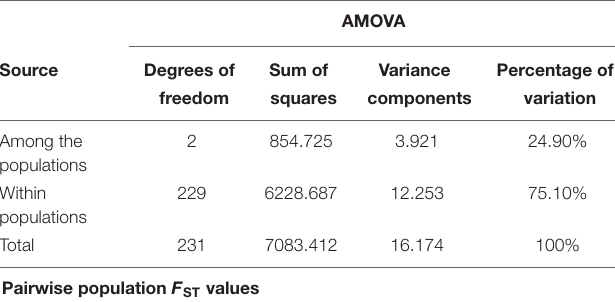
TABLE 1 | AMOVA between structured landraces and pairwise comparison using F ST values